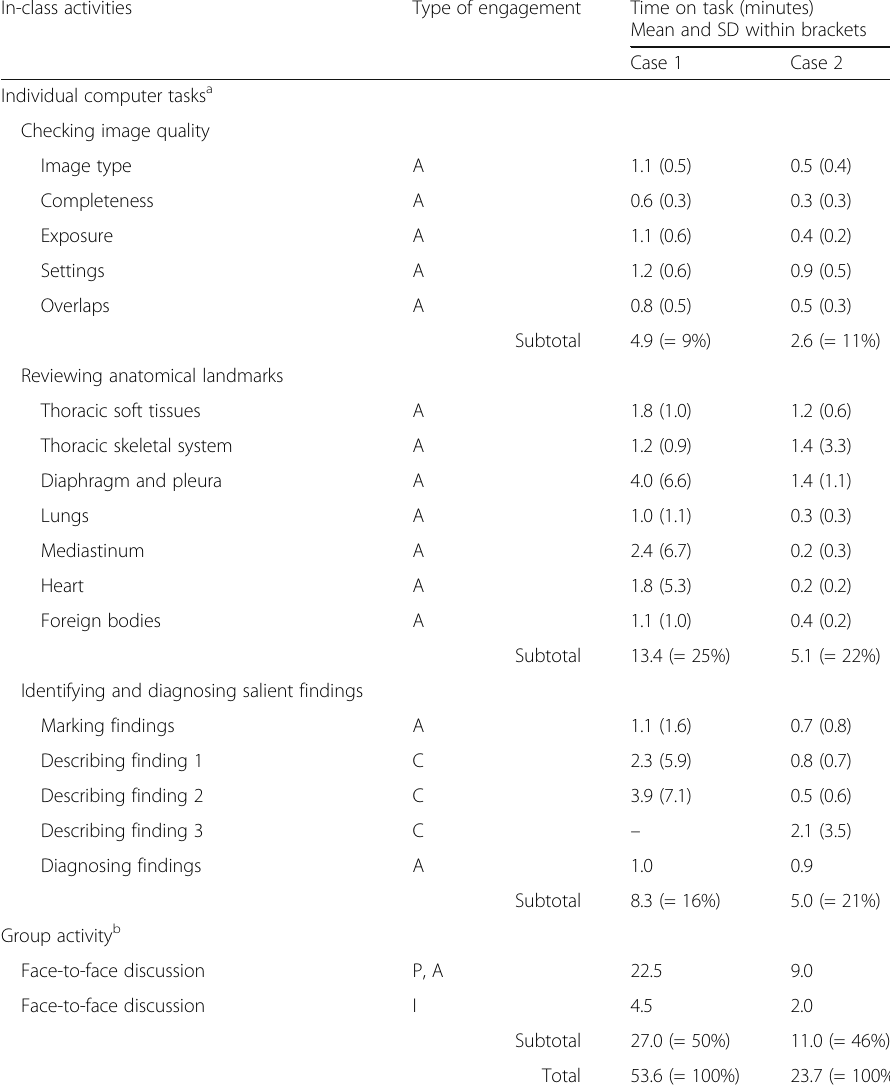
Table 1 Students ’ time on task during the in-class scenario In-class